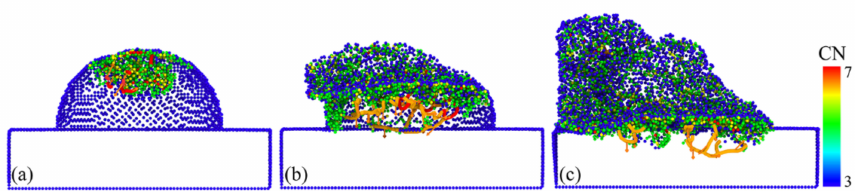
Figure 18. Cross-sectional image of dislocation movement and phase transformation distribution at different plowing depths of ( a ) 2 nm, ( b ) 4 nm and ( c ) 7